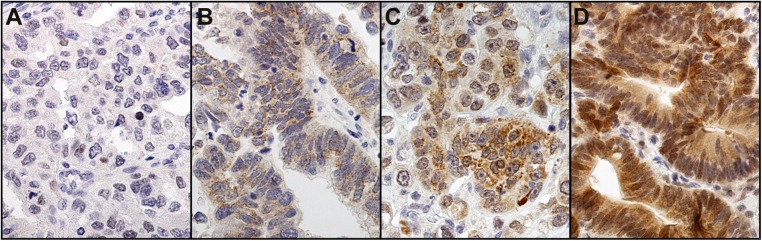
Representative images of PROX1 staining representing gastric cancer tumors with negative (A), weak (B), moderate (C), and strong (D) staining.Original magnification 40x.